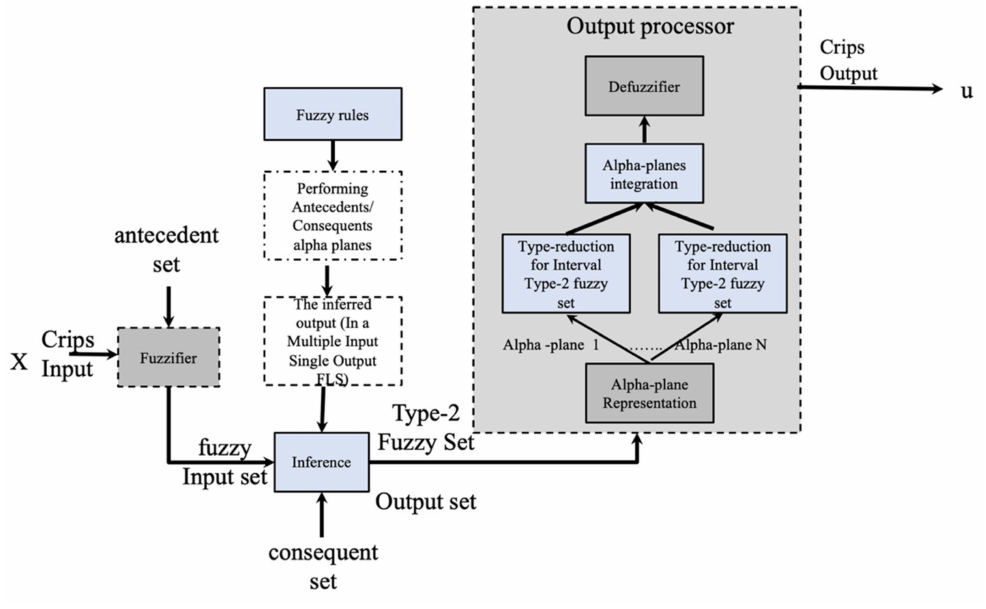
Figure 3. Structure of a GT2FLS.